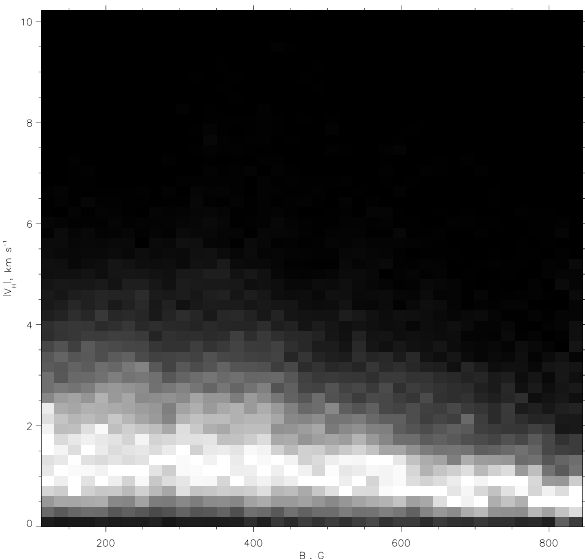
Fig. 2. Scatter plot of modulus of the horizontal velocity versus the strength of the vertical magnetic field